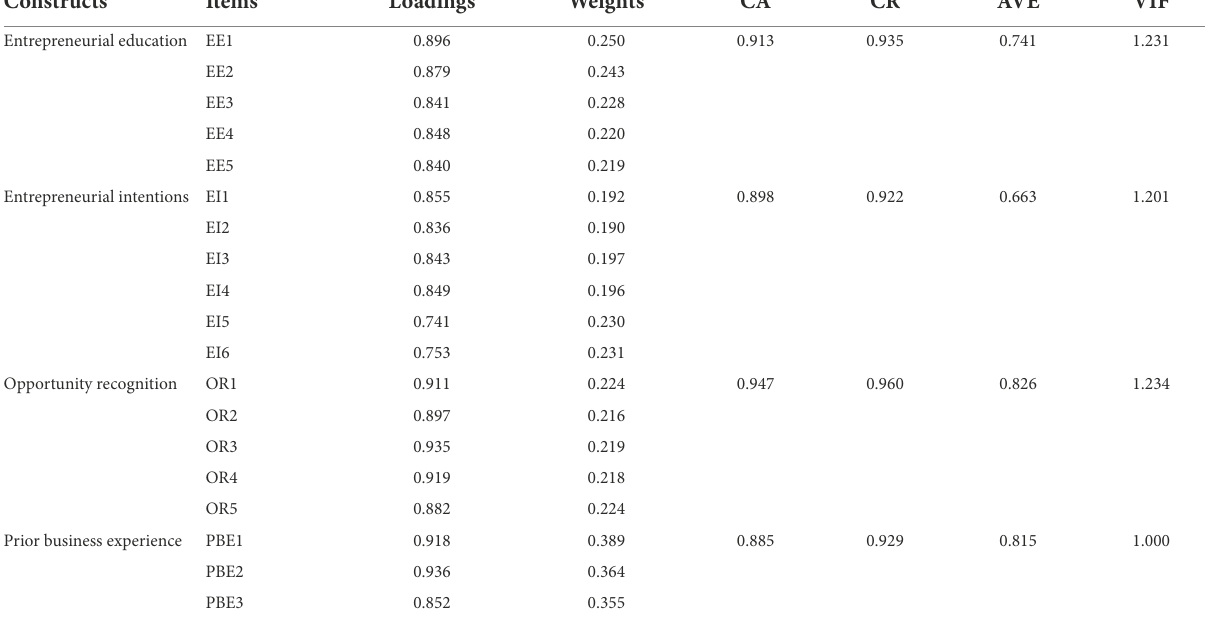
TABLE 3 Measurement model.